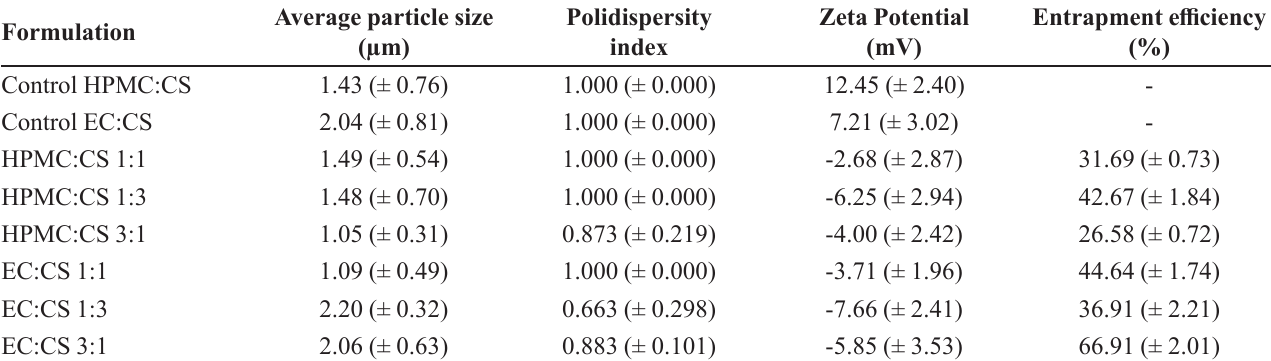
TABLE II - Results of microparticles characterization